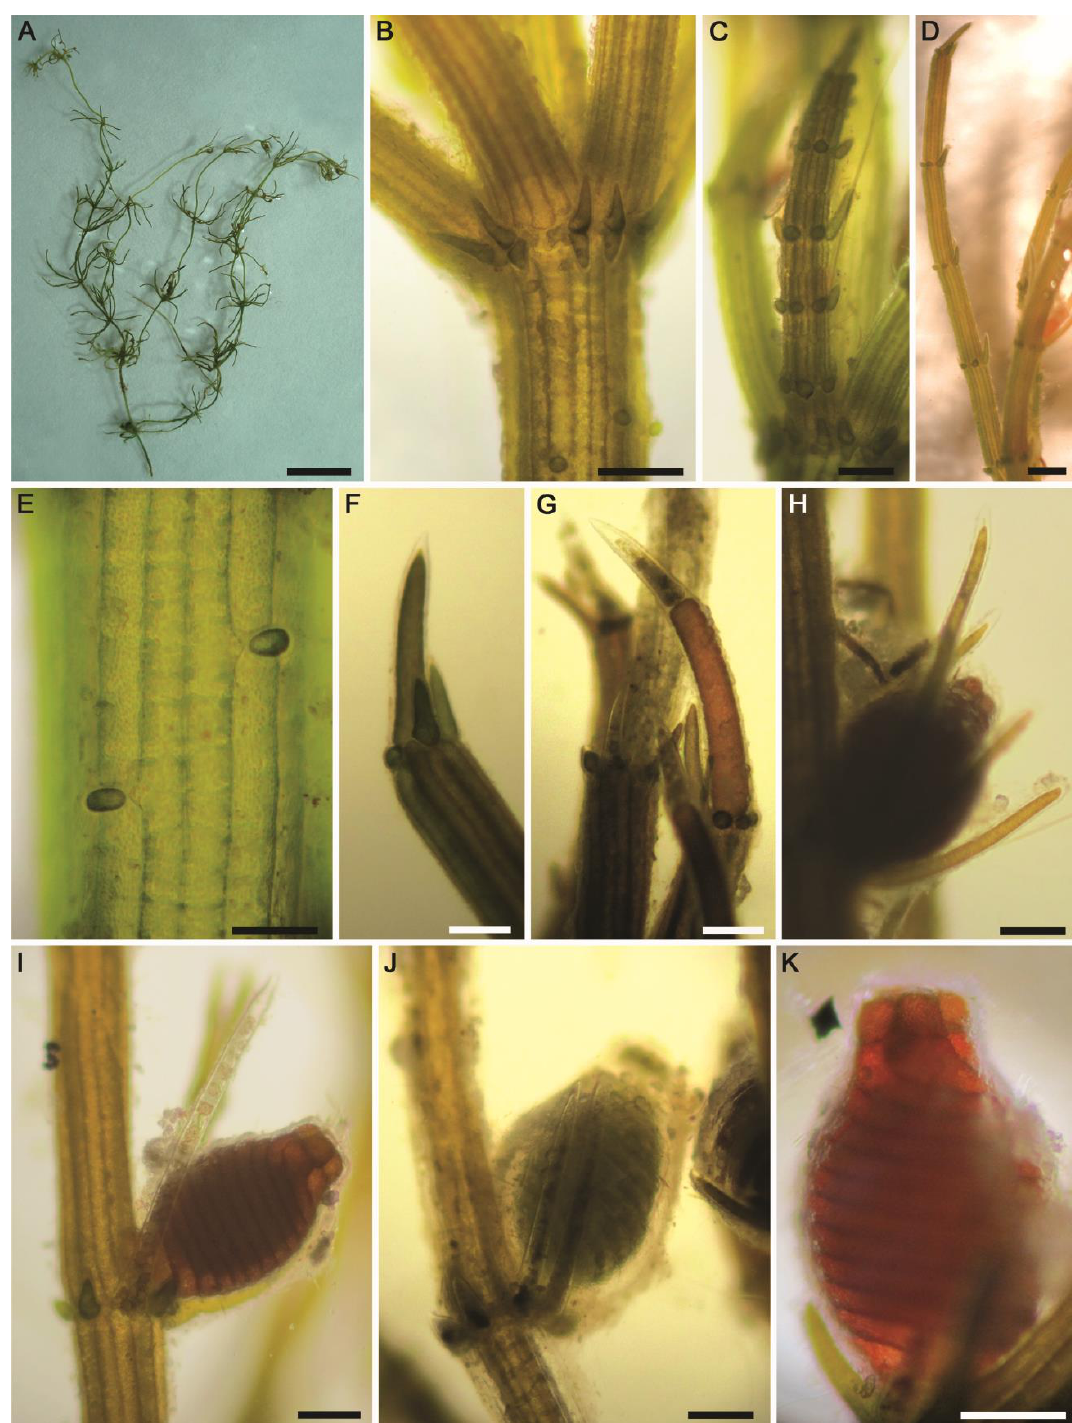
Figure 5. Morphotaxonomic features of Chara aspera found in a mineral spring-fed agricultural ditch in the Siwa Oasis (the Western Desert of Egypt): ( A ) Macroscopic habitus of female plant; ( B ) axial node showing stipulodes, papilliform spine-cells, and triplostichous tylacanthous cortex; ( C , D ) branchlets of female plant; ( E ) Triplostichous isostichous cortex; ( F , G ) apices of branchlets with 1 – 2-celled end segments; ( H – K ) parts of the branchlets depicting oogonia, bract-cells, bracteoles and coronula. Scale bars: ( A ) = 2 cm; ( C,D ) = 1 mm; ( B,F – K ) = 200 μ m; ( E ) = 100 μ m.